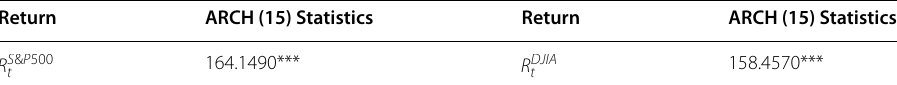
Table 7 Tests for ARCH Effect: 01/01/2019–06/30/2020